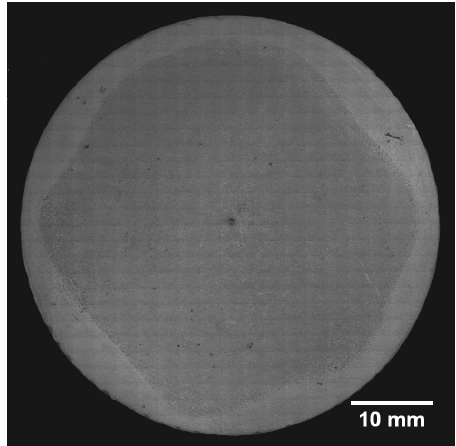
Figure 1. Cross-sectional macrostructure of the ingot.